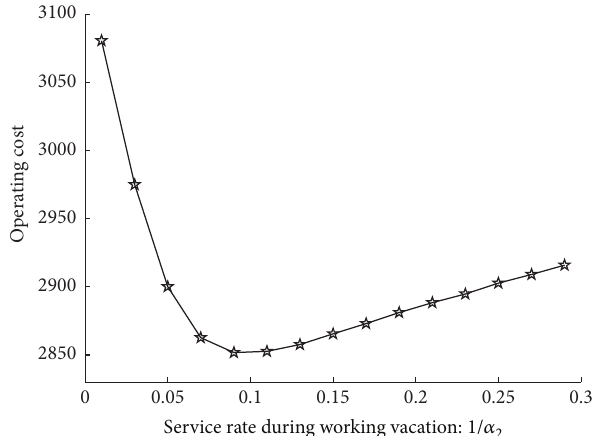
Figure 5: Effect of 1 /𝛼 2 on the operating cost per unit